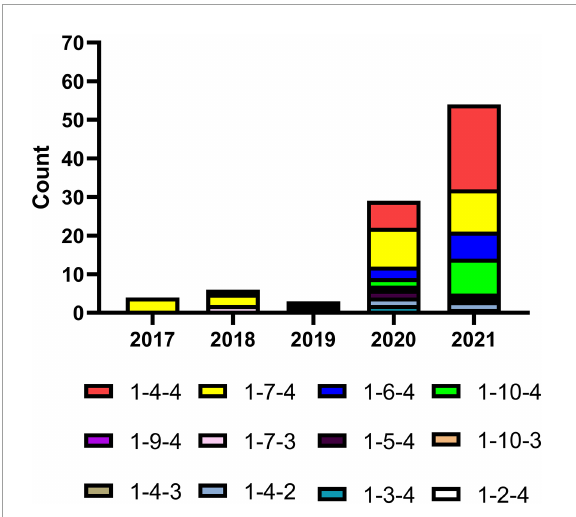
FIGURE4 Restriction fragment length polymorphisms (RFLPs) in the ORF5 gene of NADC34-like strains in China. Some RFLPs in ORF5 had not previously been associated with Hin cII digestion. These patterns were artificially divided into patterns 9 and 10. The number of RFLP patterns identified in Chinese NADC34-like strains, as well as the relative abundances of patterns 1-4-4 and 1-7-4, increased between 2017 and 2021. The relative abundances of patterns 1-6-4 and 1-10-4, which were only reported recently, have also increased gradually. This graph was produced using Graphpad Prism V 7.03 (GraphPad Software Inc., San Diego, CA, United States).